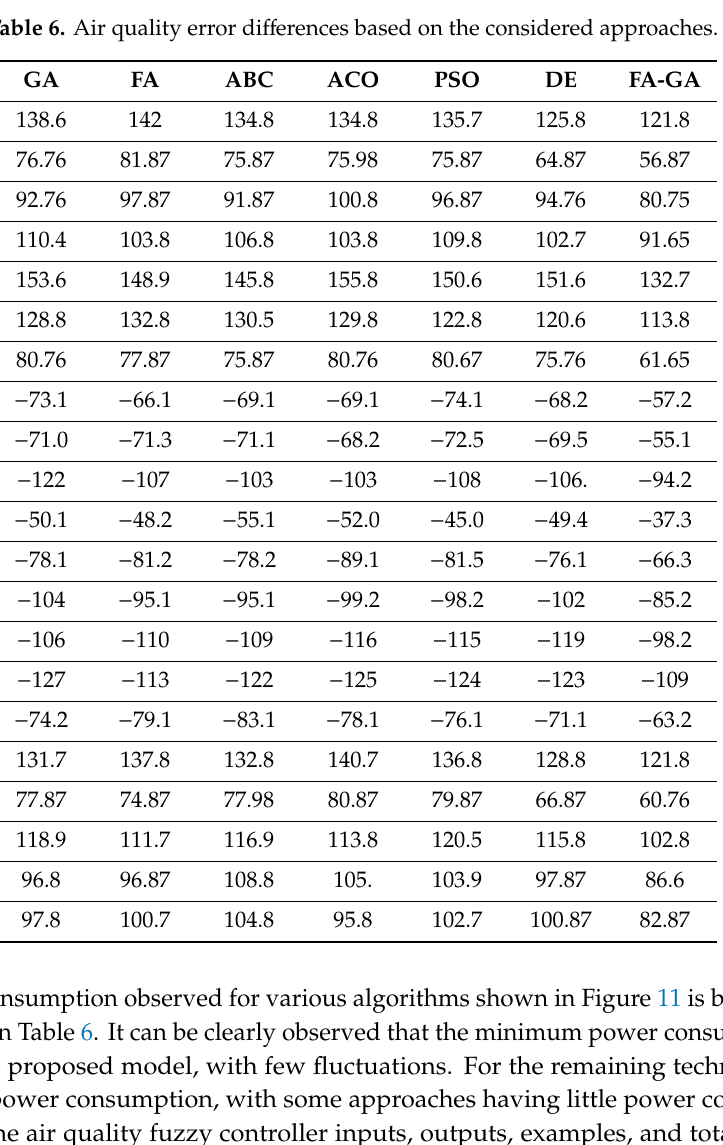
Figure 12. Air quality fuzzy controller inputs. Figure 13. Air quality fuzzy controller inputs and outputs relationship.